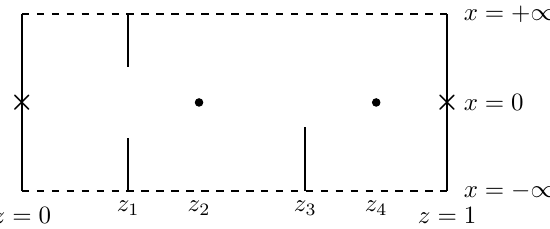
Figure 1 . Schematic form of the electrostatic problem associated with a generic quiver. At z = 0 and z = 1 Dirichlet boundary conditions are imposed, which are vanishing aside from (cid:14) -functions at the marked points. The black dots at x = 0 represent point charges due to fundamental (cid:13)avors at interior nodes. The solid lines at z = z 1 and z = z 3 represent perfectly conducting plates at interior nodes with N f 6 = 2 N , with total charge given by the discontinuity in @ z N ( z ). The node at z = z 3 has maximal Chern-Simons level, so that the support of % is bounded only on one side; the Chern-Simons level at the z = z 1 node is